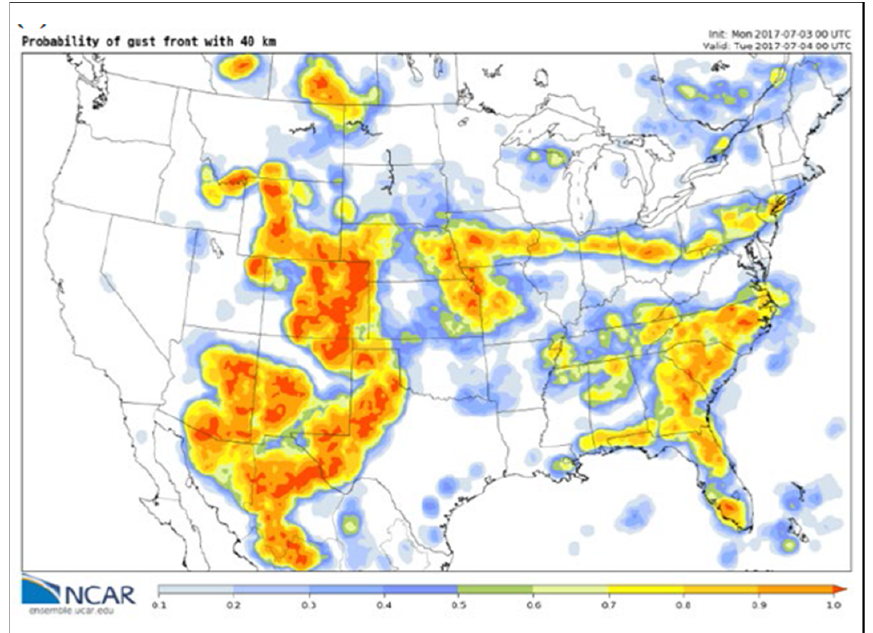
Figure 2. Probability of a gust front within 40 km of a given point. Probabilities run from 0% (white) to 100% (red), color probability scale (0–1) at bottom. The results are valid for a 24 h ensemble forecast valid at 0000 UTC 4 July 2017. Figure from [8] (their Figure 6).